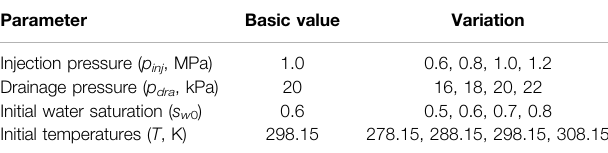
TABLE 2 | Simulation schemes of different in fl uencing